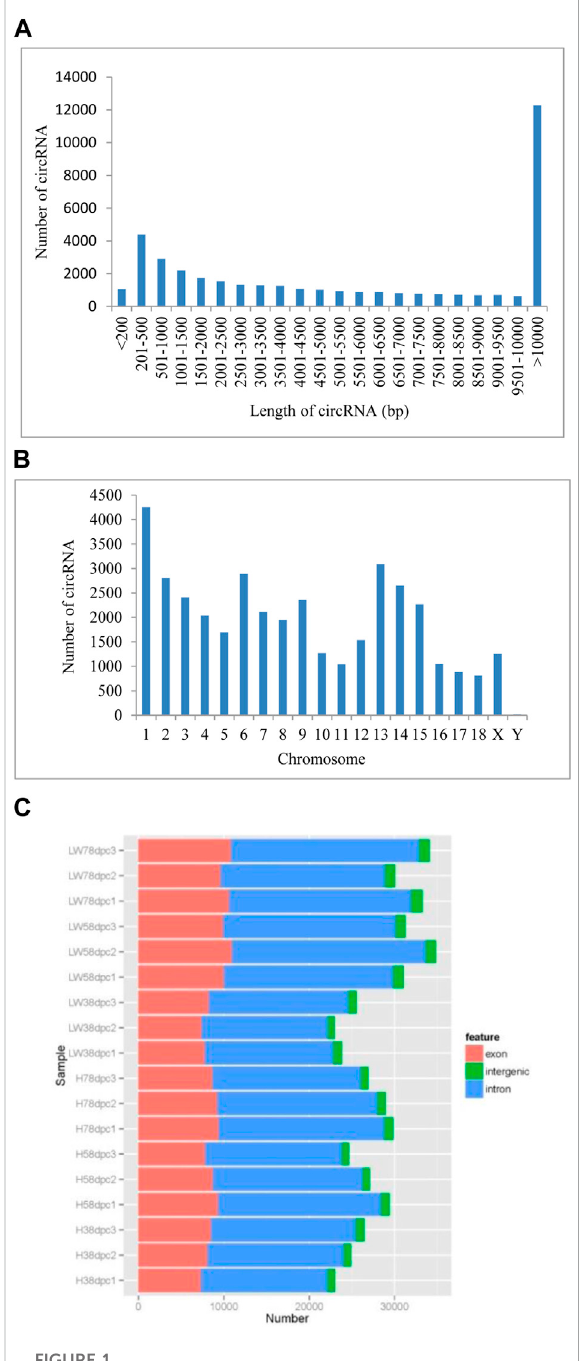
FIGURE 1 The genomic features of novel circRNAs in LD muscle of HN and LW at different embryonic periods (A) Length distribution of novel circRNAs. (B) Chromosome distribution of novel circRNAs. (C) Classi fi cation of the novel